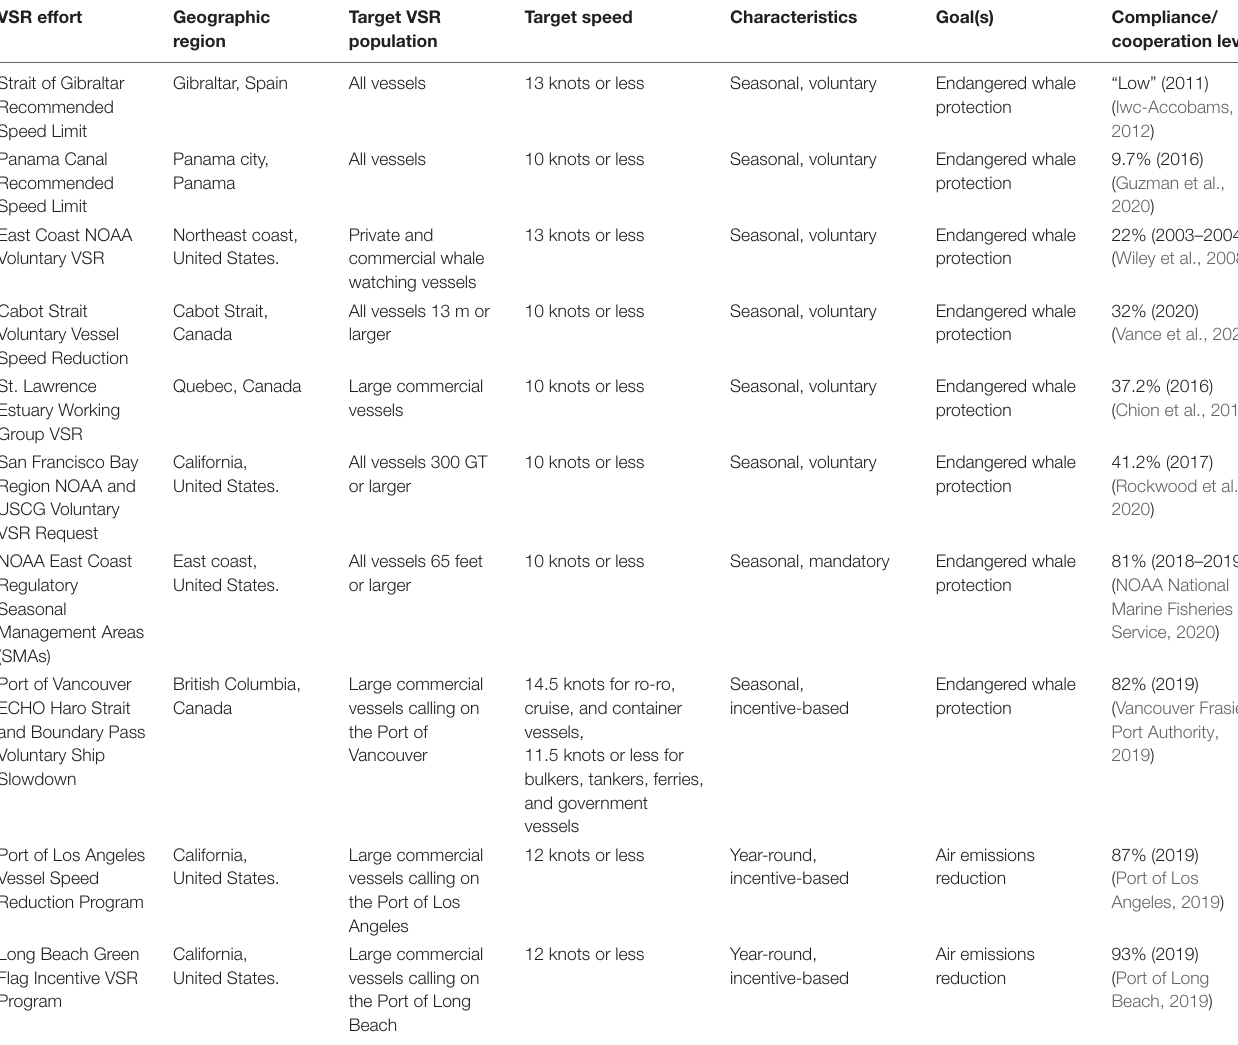
TABLE 1 | Vessel Speed Reduction (VSR) efforts aimed at endangered whale protection and air emissions